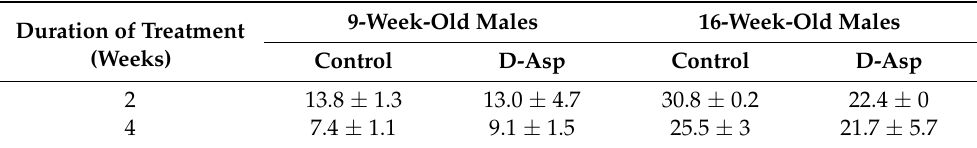
Table 2. Sperm concentration (million/mL) of 9-week-old and 16-week-old males (mean ± SD). Duration of Treatment